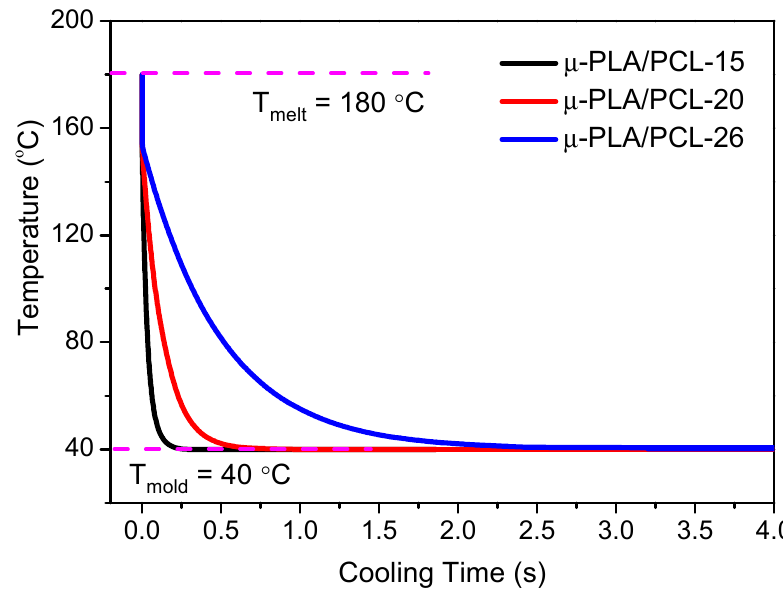
Figure 3. The cooling dissipation curves of microparts with different cavity size. Table 2. The cooling parameters of microparts with different cavity size.